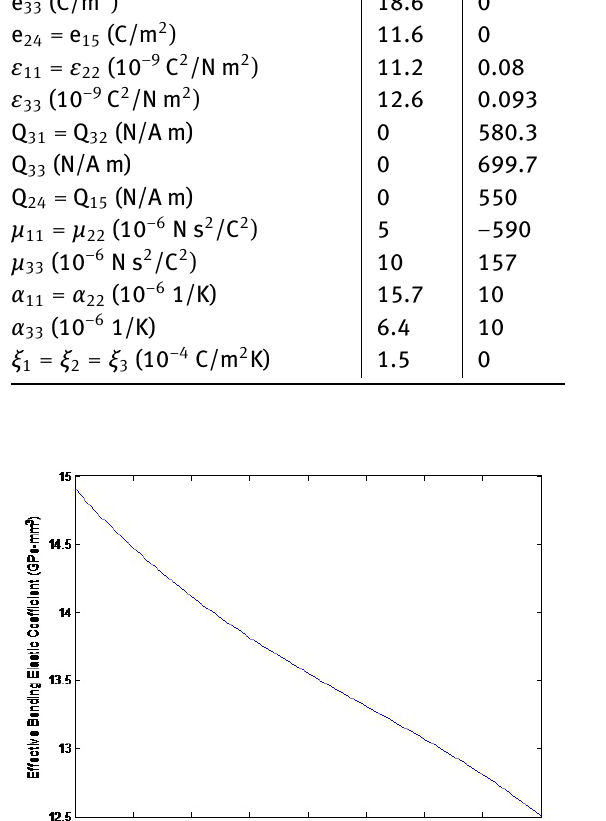
Figure 2: Plot of effective ness of the BaTiO 3